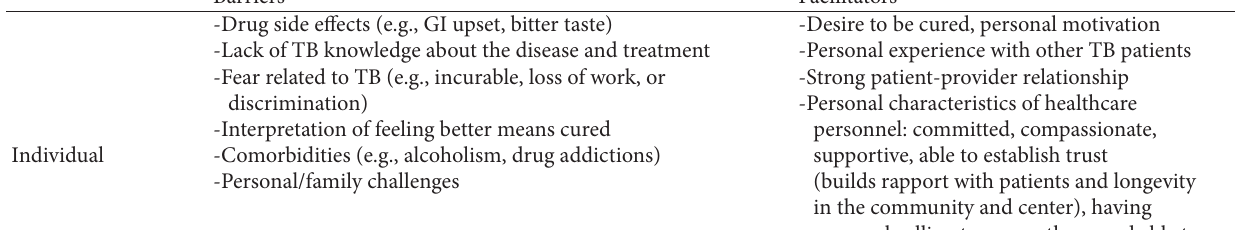
Table 1: Barriers to and facilitators of successful completion of treatment by category. Barriers